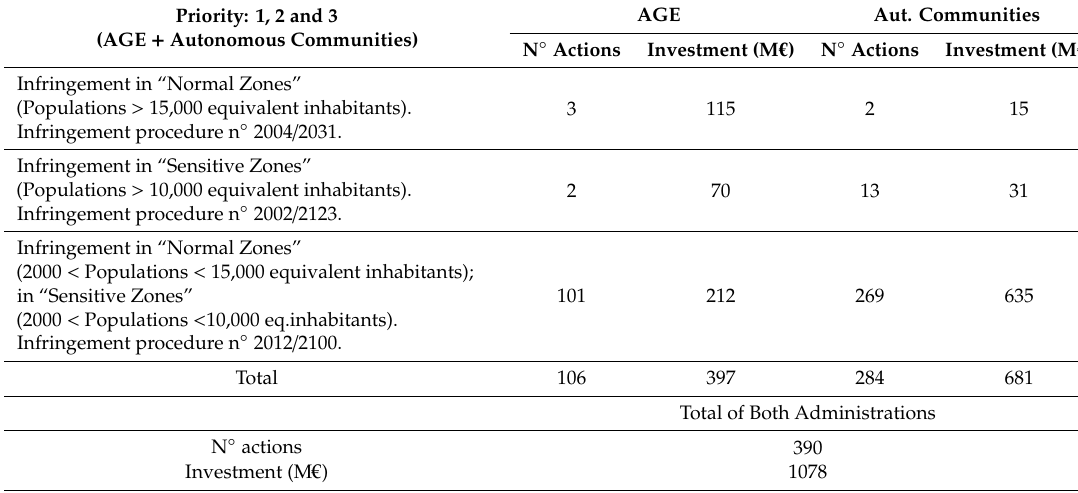
Table 3. Estimated actions and investments, according to priority, until 2027 to resolve infringement proceedings of Directive 91 / 271 / EEC. Source: own elaboration based on [58,60]. AGE Aut. Communities Priority: 1, 2 and 3 (AGE + Autonomous Communities) N ◦ Actions Investment (M € ) N ◦ Actions Investment (M € ) Infringement in “Normal Zones” (Populations > 15,000 equivalent inhabitants). 115